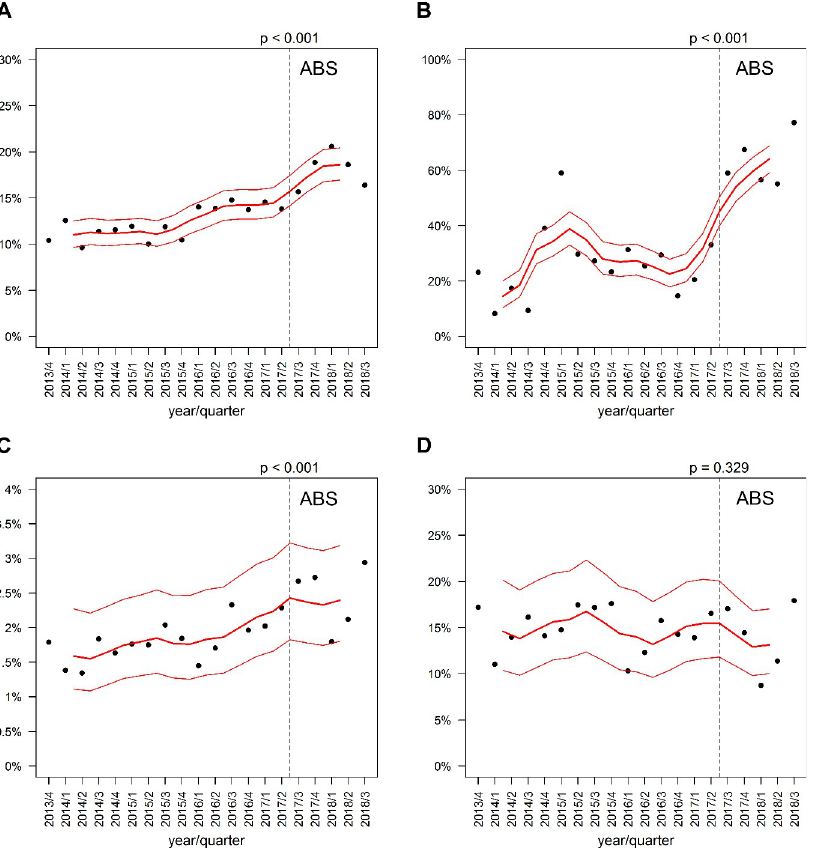
Fig 1. Impact of the diagnostic ABS bundle in the ED. (A) Percentage of hospitalised ED encounters with BCs obtained. (B) Percentage of ED encounters with BCs obtained with two or more BCS collected. (C) Detection rate of bacteraemia in hospitalised ED encounters. (D) Diagnostic yield of true bacteraemia. The dotted line represents the introduction of the new diagnostic ABS bundle. The red line represents the moving average estimator with n = 4 and its 95% confidence interval. P -values were obtained by chi-squared